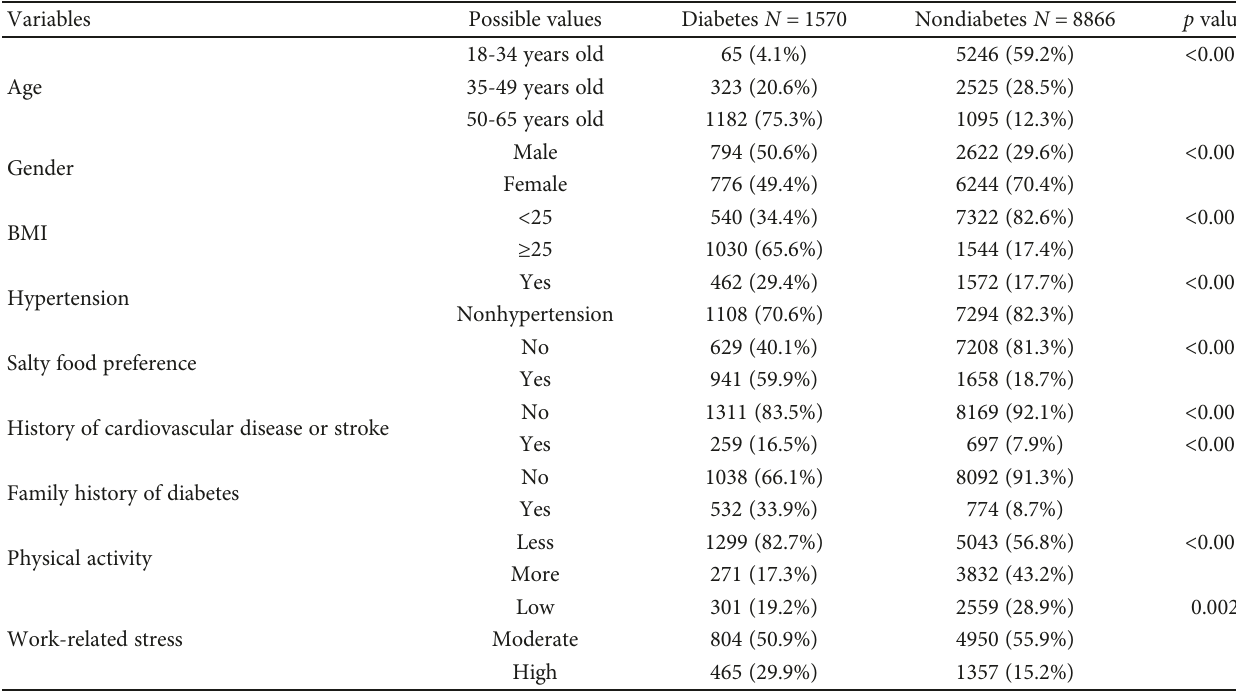
Table 1: Characteristics of